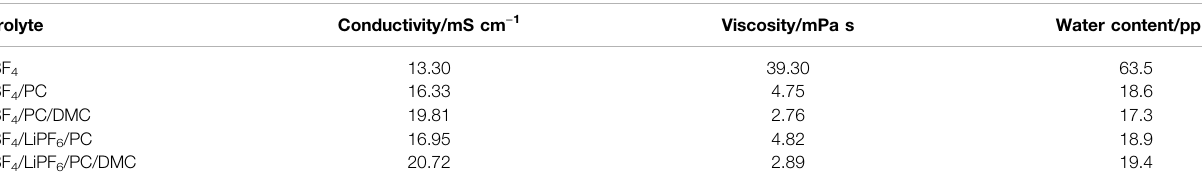
TABLE 2 | ionic conductivities, viscosities, and water contents of various electrolytes at 25 ° C. Electrolyte